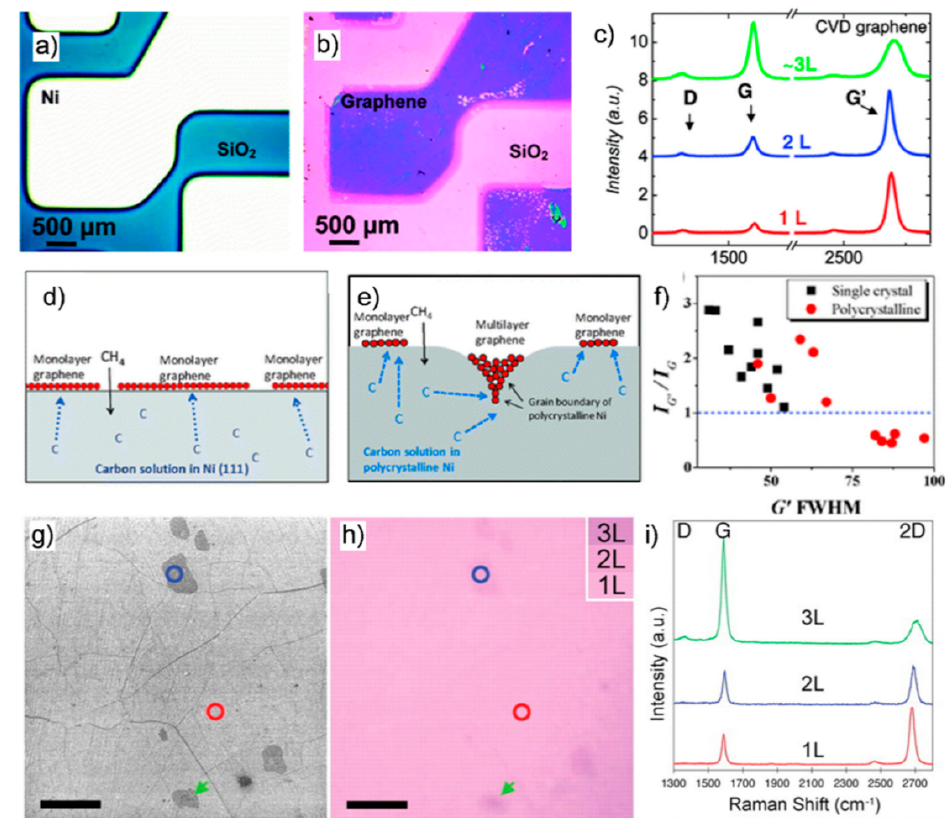
Figure 1. Metal catalyst assisted growth of graphene: ( a ) Micrograph of a patterned Ni film on SiO 2 /Si; ( b ) Micrograph of the grown graphene transferred to targeted SiO 2 /Si substrate; ( c ) Raman spectroscopy of the transferred graphene film; ( d ) Schematic presentation of graphene growth mech- anism on Ni (111); ( e ) Schematic diagrams of graphene growth mechanism on polycrystalline Ni surface; ( f ) The I G (cid:48) /I G intensity ratio versus the FWHM of G (cid:48) peak of graphene grown on Ni (111) and polycrystalline Ni; ( g ) SEM image of the transferred graphene; ( h ) Micrograph of the transferred graphene; ( i ) Raman spectra taken from different points of the transferred graphene film. ( a – c ) Re- produced with permission from [43]. Copyright American Chemical Society, 2009; ( d – f ) Reproduced with permission from [58]. Copyright American Chemical Society, 2010; ( g – i ) Reproduced with permission from [42]. Copyright Science,